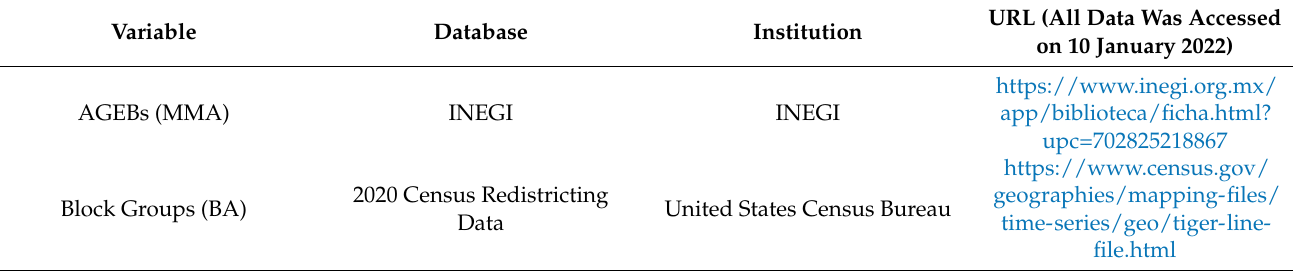
Table 6. Datasets of aggregation